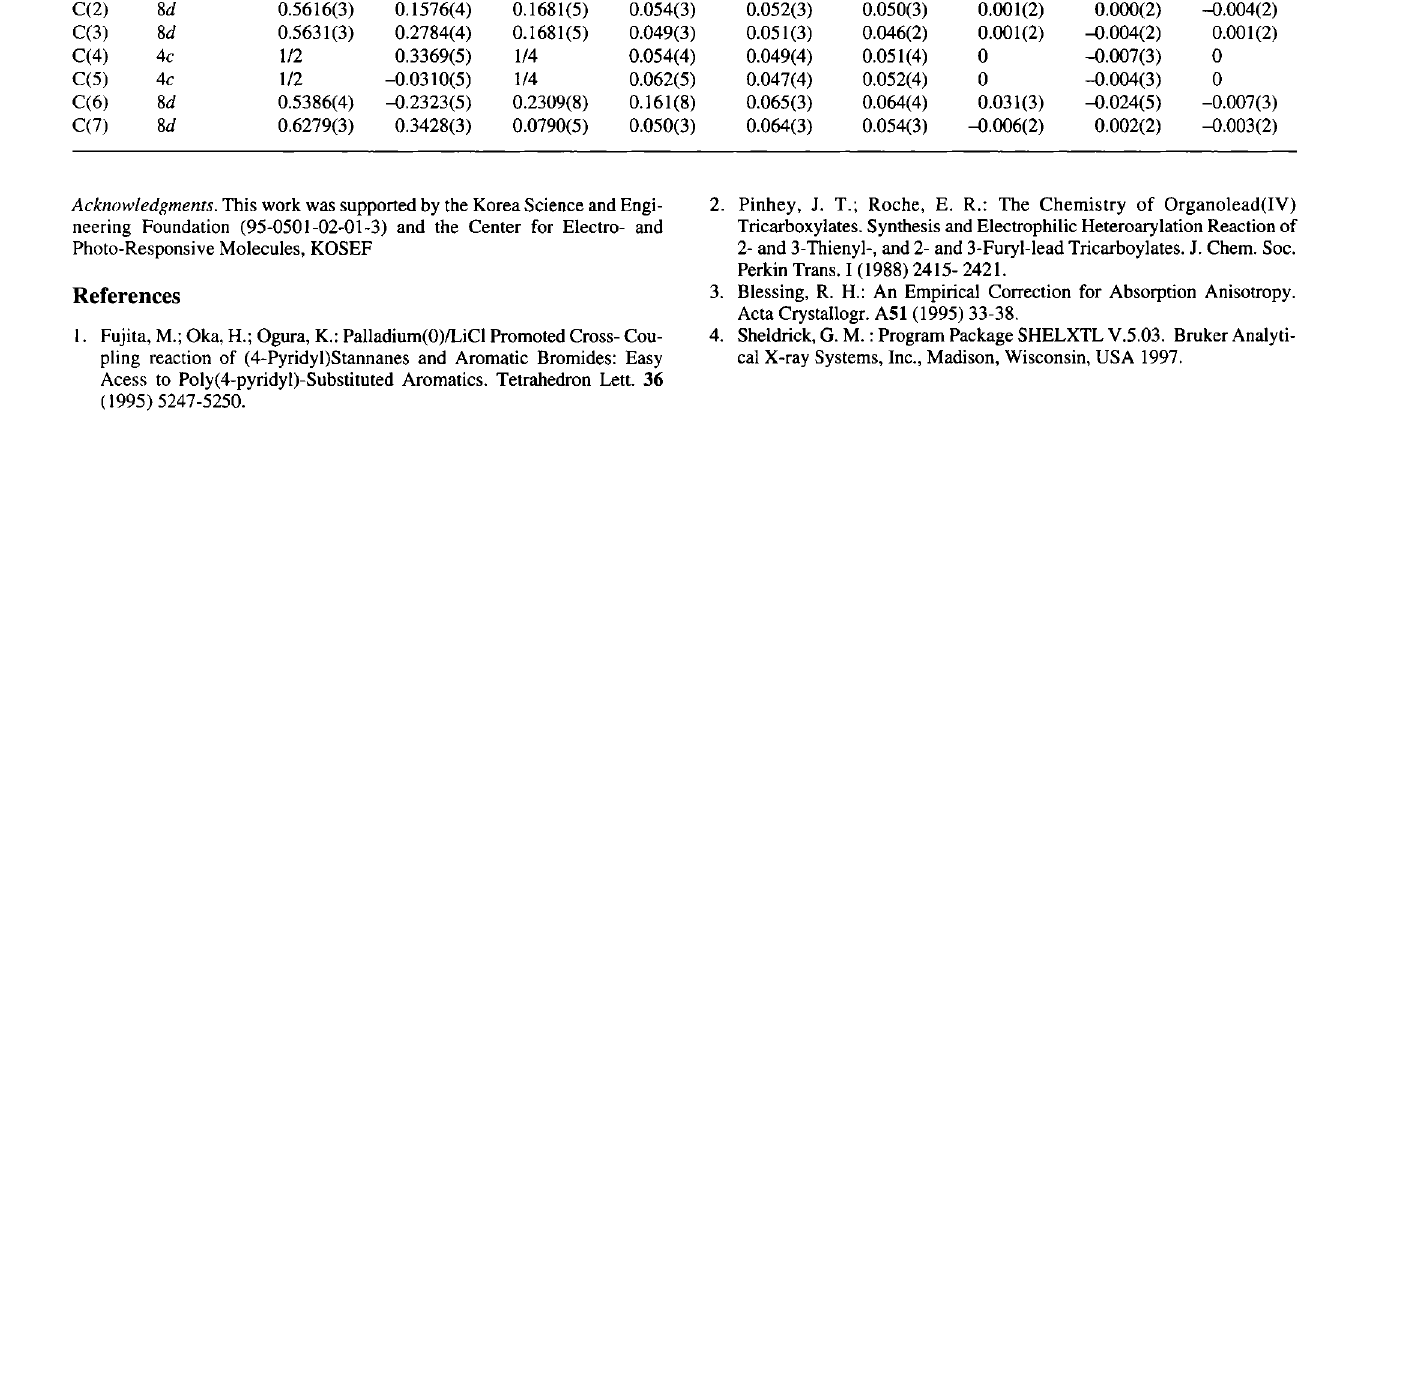
Table 3. Atomic coordinates and displacement parameters (in À 2